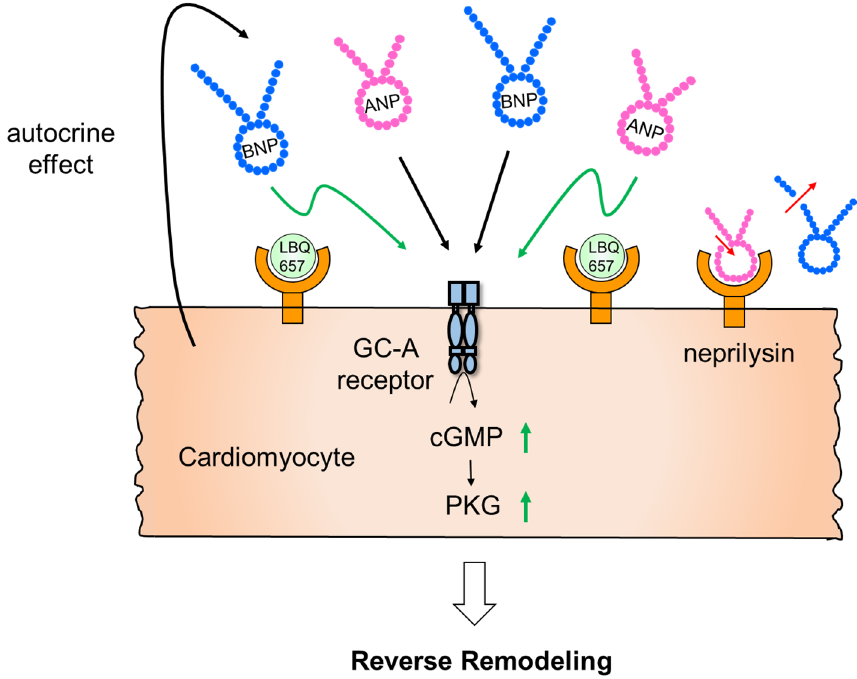
Figure 2. The effect of NEP on cardiomyocytes and the potential role of ARNI. Orally administered ARNI may directly affect the heart and lead to reverse remodeling by increasing cGMP signaling, even at high concentrations of cardiac natriuretic peptides [61]. LBQ657, sacubitrilat (the active metabolite of sacubitril).